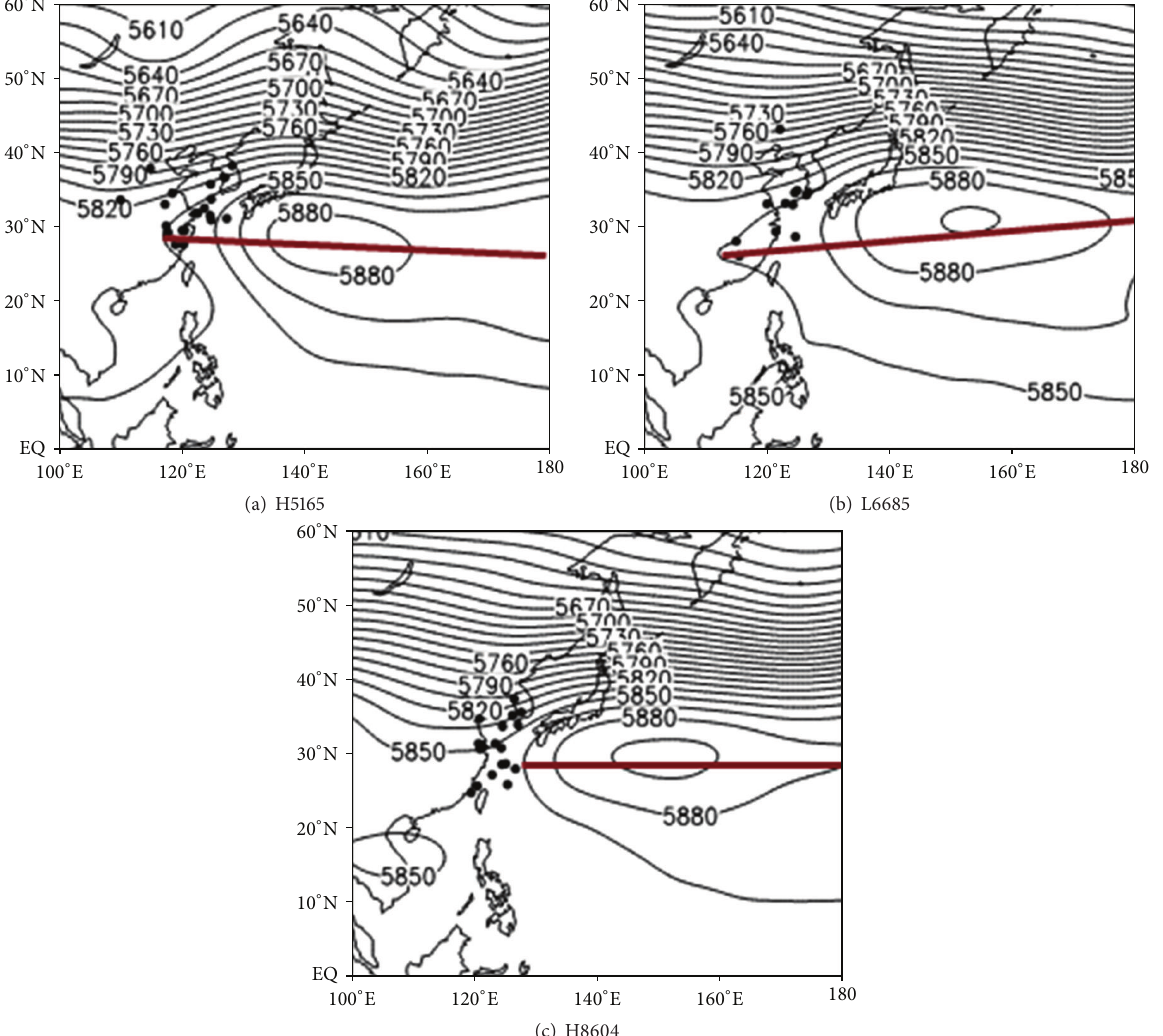
Figure 8: Composites of geopotential heights at 500 hPa for the periods of (a) H5165, (b) L6685, and (c) H8604. Dots denote recurving locations of TCs. Brown sold lines denote ridges of